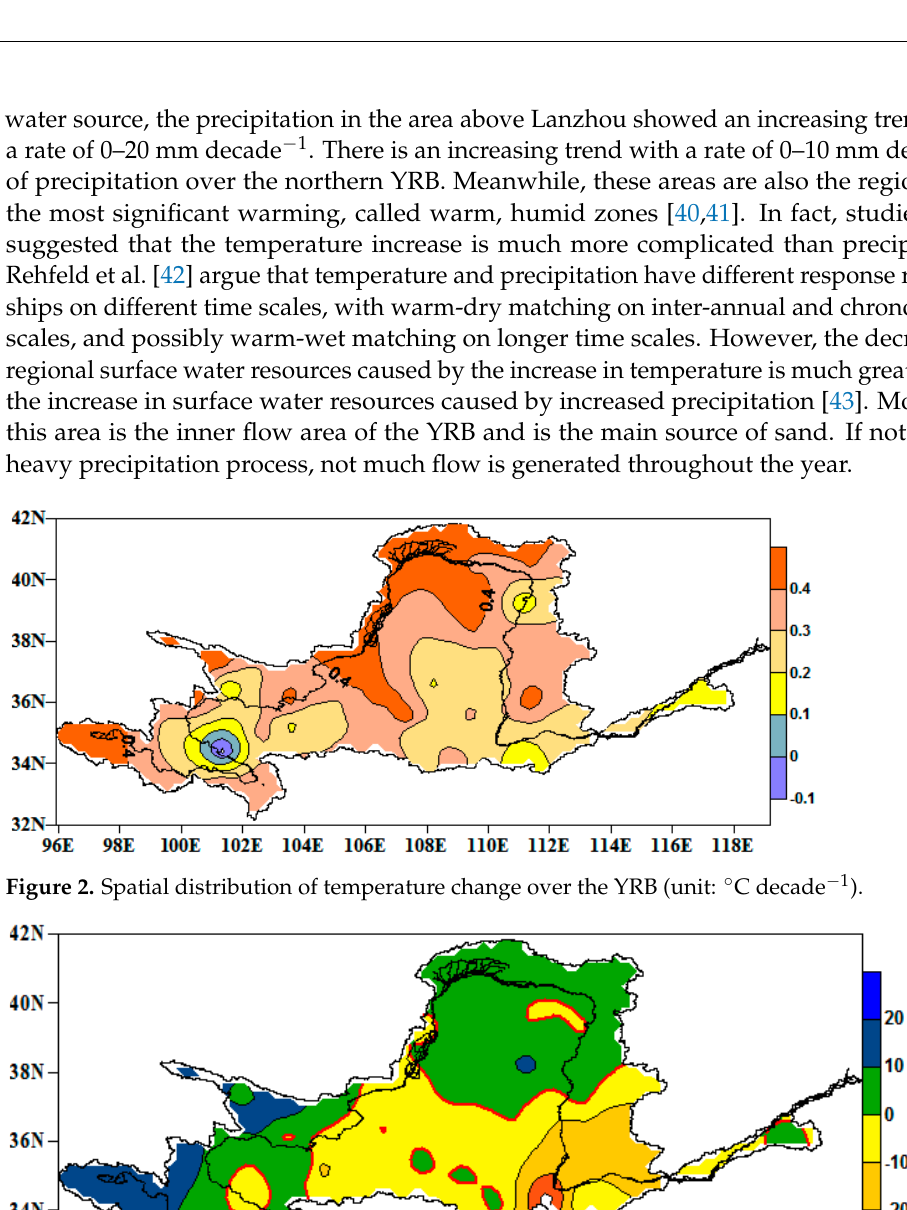
Figure 3. Spatial distribution of annual precipitation over the YRB (the red line is the dividing line between increase and decrease; unit: mm decade − 1 ).